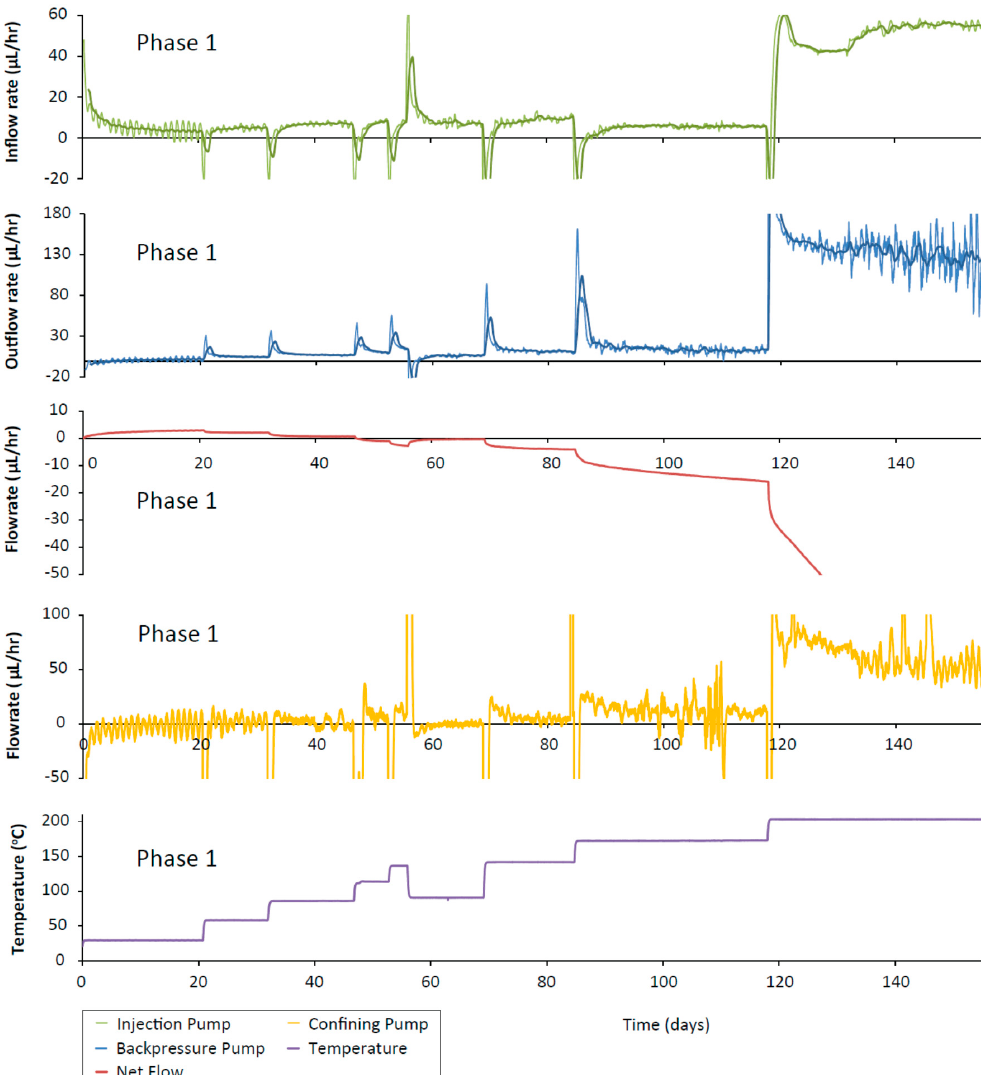
Figure 10. ISO-2 inflow (green line), outflow (blue line) and confining pump (orange line) flow-rates and vessel temperature (purple line). Data are subsampled once every 30 min and a 20 point moving average filter (representing a 10 h window) has been applied. Bold lines (green and blue) show an additional 50 point moving average filter (every 25 h). Net flow (red line) shows a decrease after each temperature increase and an increase after each temperature decrease.